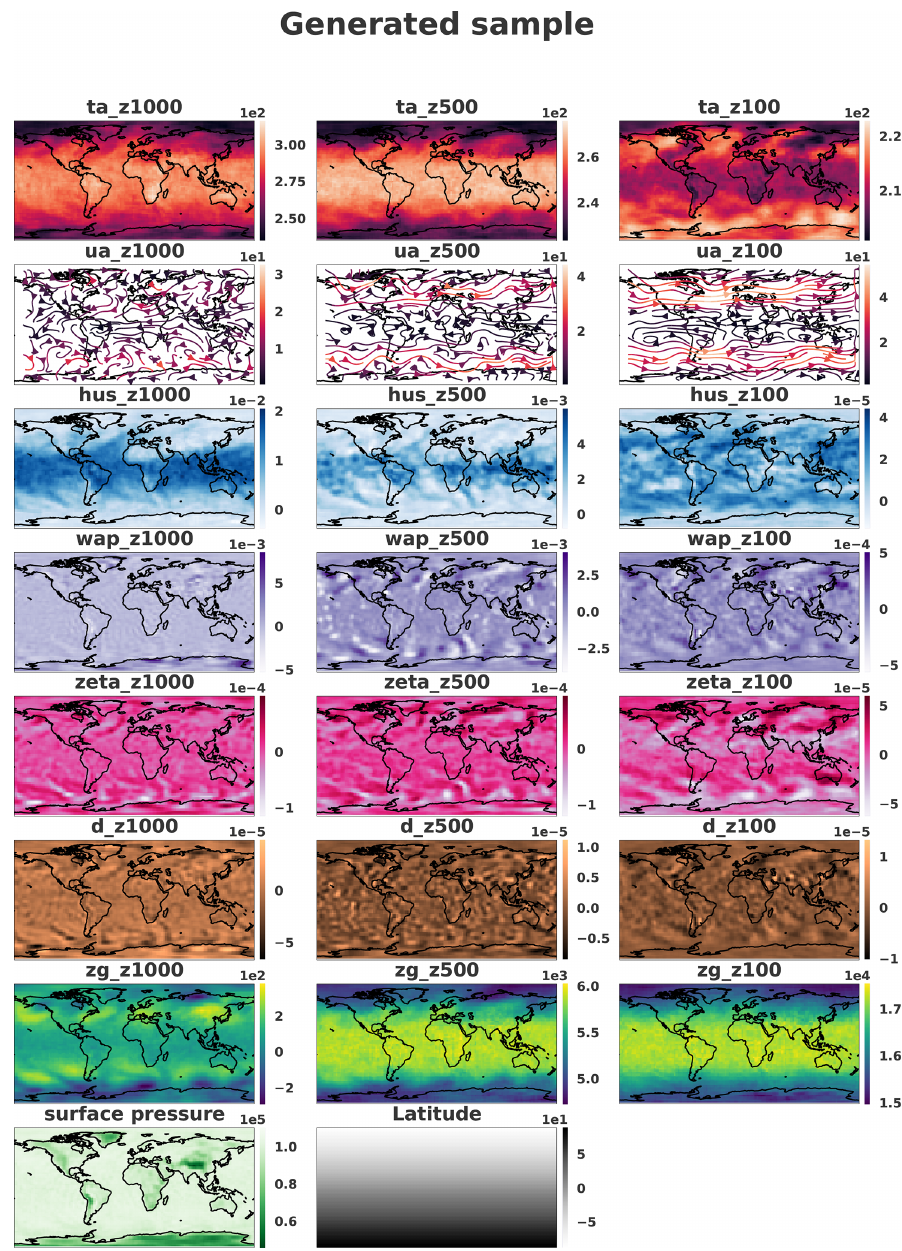
Figure 9. Sample on three different pressure levels (1000, 500 and 100hPa) generated by the network. The samples were horizontally transposed in order to have Europe at the center of the images to verify the quality of the periodic boundary. Coastlines were added a posteriori for